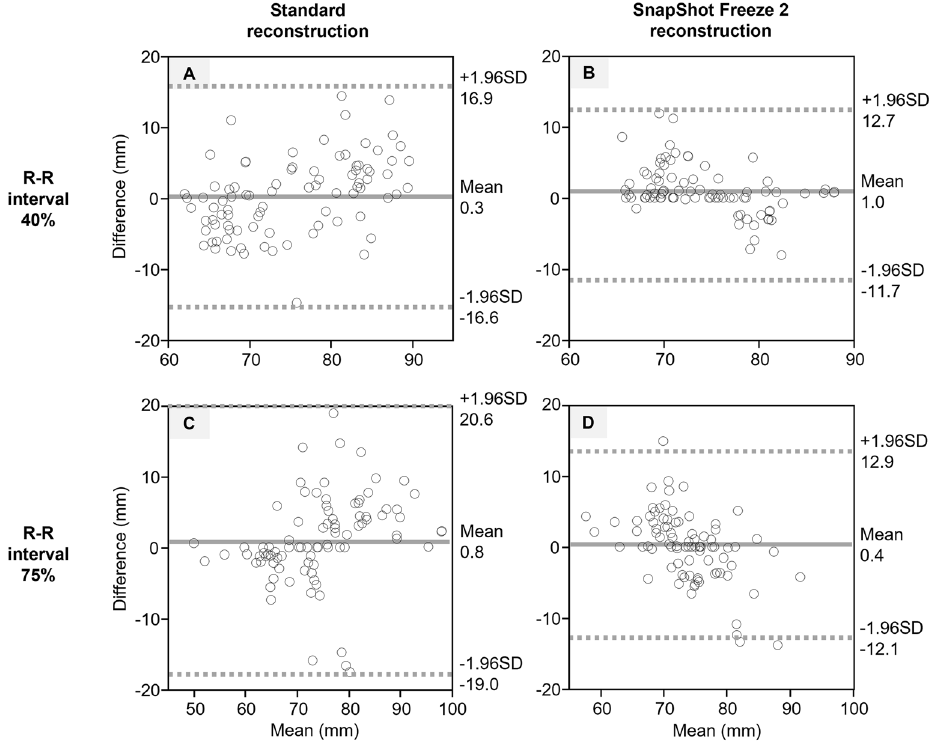
Figure 4. Bland–Altman plot analysis of interobserver agreement with respect to the aortic annulus perimeter. Standard- and SSF2 reconstruction at an R-R interval of 40% ( A and B ) and standard- and SSF2 reconstruction at an R-R interval of 75% ( C and D ). The solid line represents the mean difference and the dashed lines the 95% limit of agreement (mean difference ± 1.96 SD). SD = standard deviation.